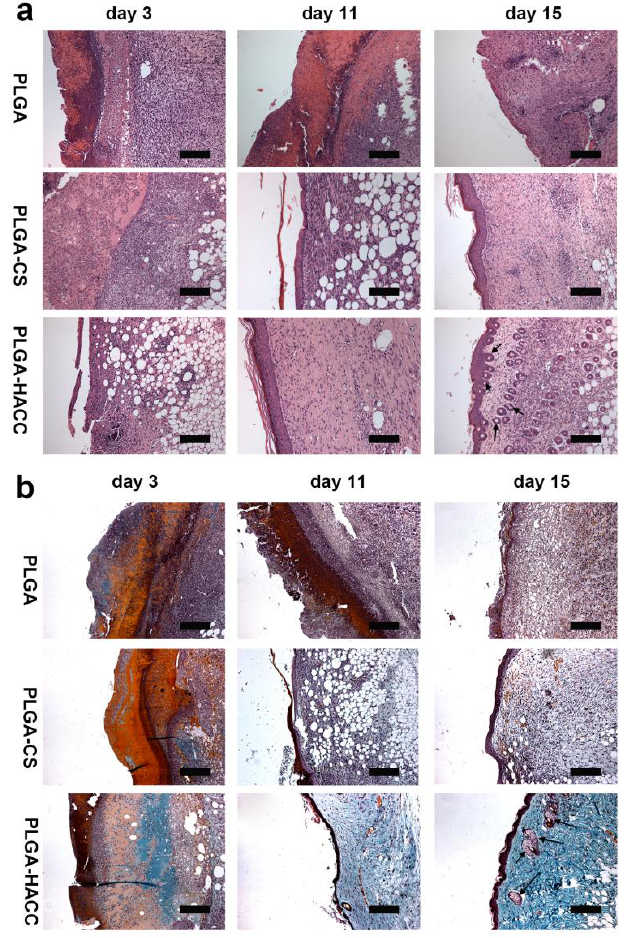
Figure 9. HE staining ( a ) and Masson’s trichrome staining ( b ) of wound healing in the groups of PLGA, PLGA-CS and PLGA-HACC fibrous membranes. The scale bar is 50 μm.